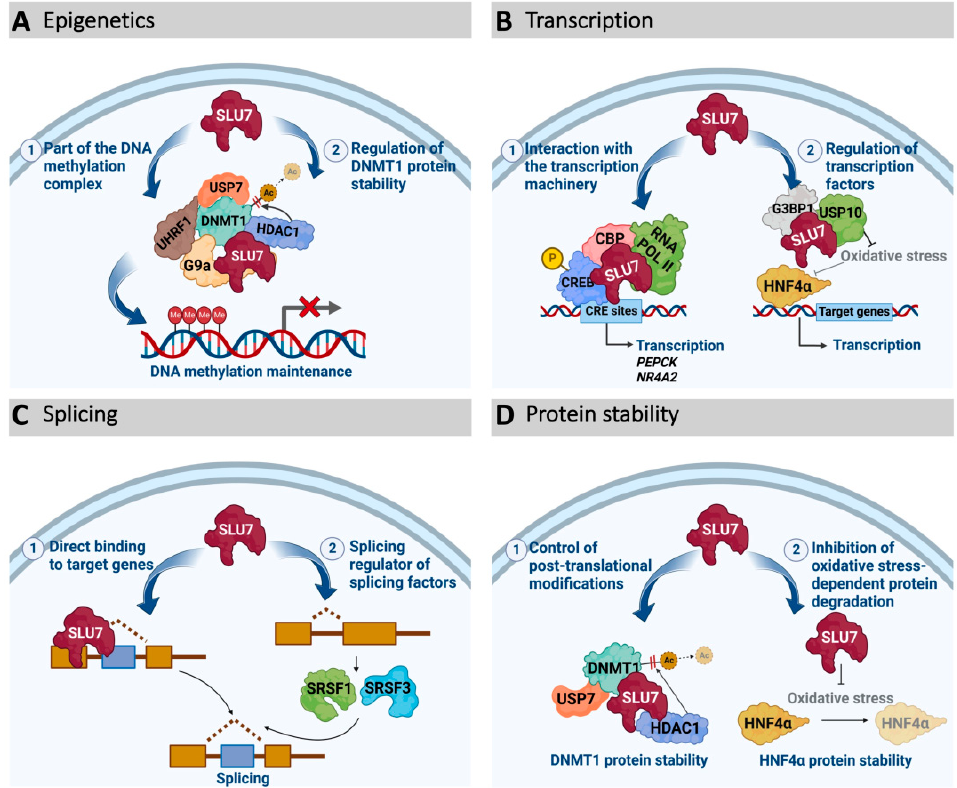
Figure 4. Schematic representation of SLU7 participation at different levels of gene expression regulation. ( A ) SLU7 acts as an epigenetic modulator by participating in the DNA methylation complex and by regulating the protein stability of DNMT1. ( B ) SLU7 regulates transcription by interaction with transcriptional complexes (cAMP-induced complex) or by regulating the expression of transcription factors (HNF4 α 1). ( C ) SLU7, through its canonical function as a splicing factor, regulates the splicing of numerous genes, either by direct binding to different targets or by regulating the splicing and expression of other splicing factors. ( D ) SLU7 regulates protein stability through the control of post-translational modifications, as in the case of the acetylation of DNMT1, or by inhibiting oxidative stress-mediated protein degradation, as in the case of HNF4 α 1. The cyclic adenosine 3 (cid:48) ,5 (cid:48) -monophosphate (cAMP) signaling pathway is a pivotal tissues [70] including the liver [71]. cAMP activates gene transcription by phosphorylating CRE-binding protein (P-CREB, cAMP response element-binding protein) and promoting